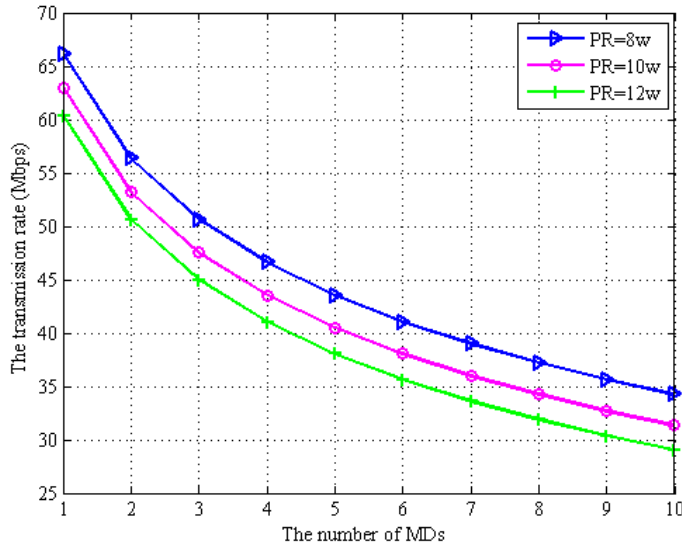
Figure 6. Energy consumption vs. the number of MDs.